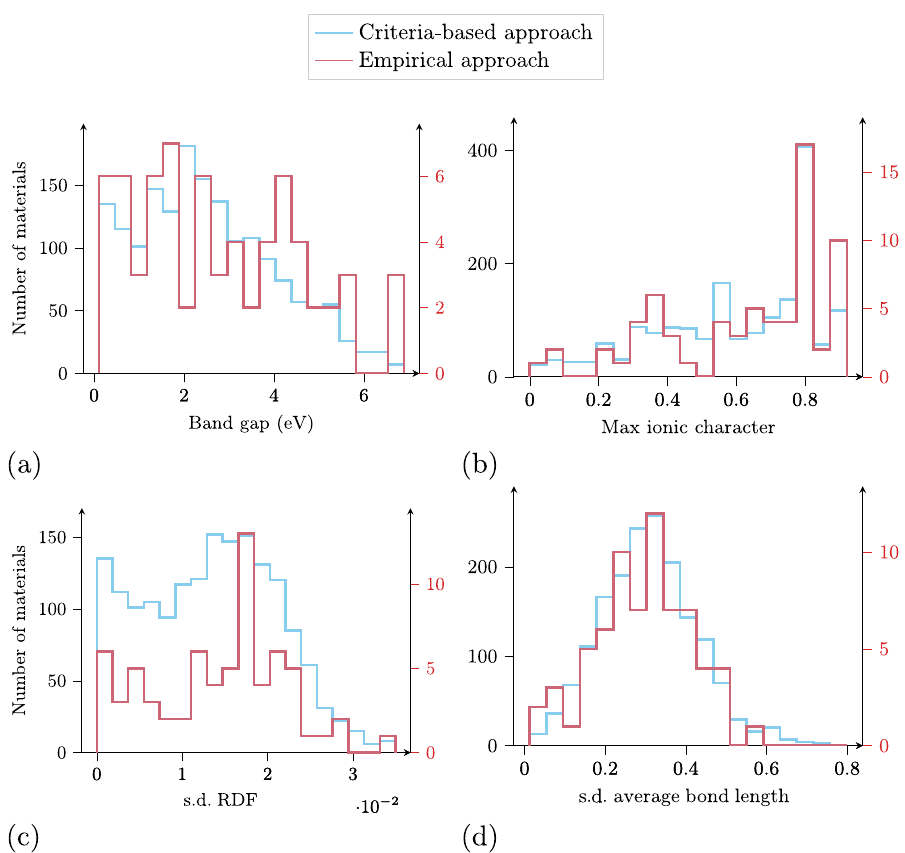
Fig. 7 Material distributions for different properties. Histograms of predicted suitable materials as a function of the ( a ) band gap, ( b ) maximum ionic character, ( c ) standard deviation of the radial distribution function (RDF) and ( d ) standard deviation of the average bond length. The total number of predicted materials is 6804 for the criteria-based approach, and 214 for the empirical approach. The criteria-based approach refers to the left y -axis and the empirical approach to the